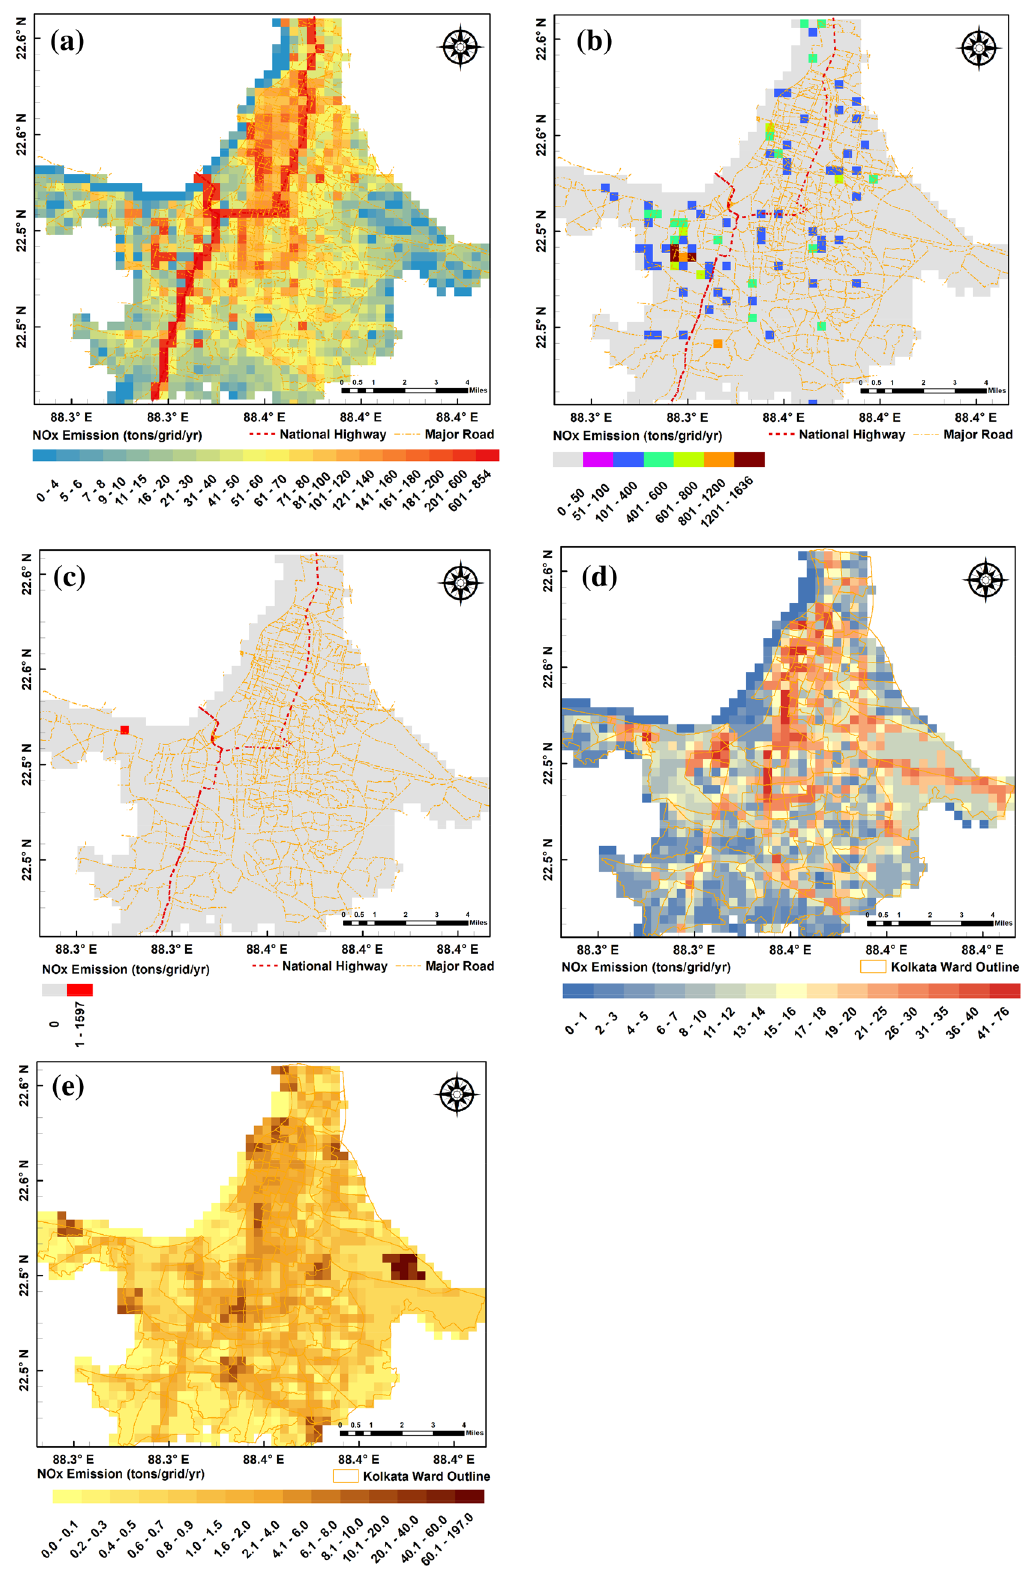
Fig. 6 Sector specific gridded annual NO emission from a Transport b Industry c Thermal power plant d Residential e x